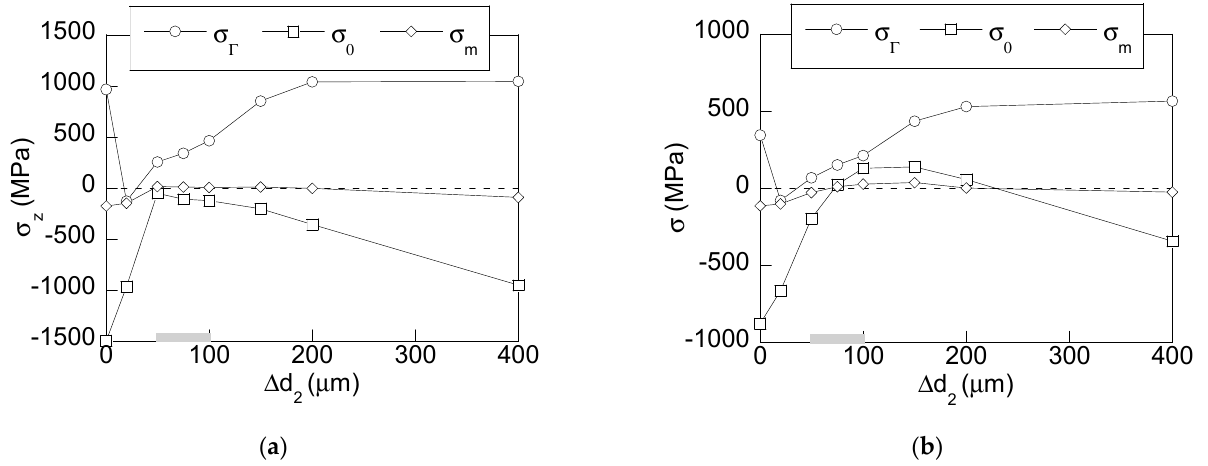
Figure 8. Variation of stress at the wire surface, the wire core and average stress with the secondary reduction applied in a skin pass wire drawing die for: ( a ) axial stress and ( b ) hydrostatic stress.